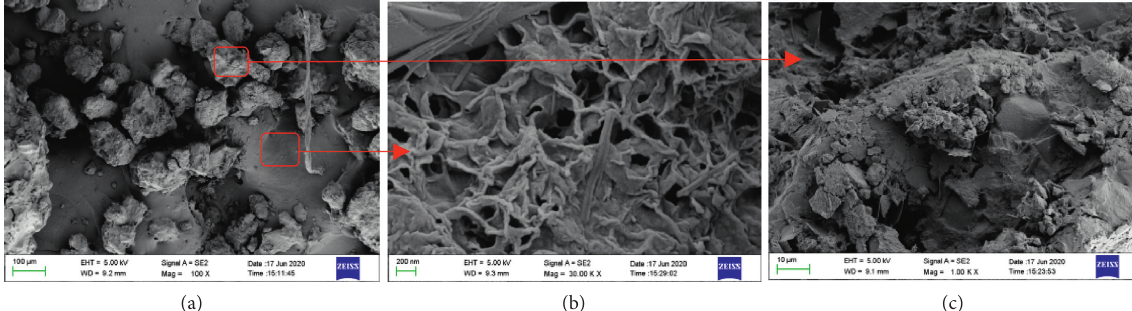
Figure 10: Microstructure of saline soils stabilised with Ca(OH) 2 and GGBS. (a) Close-up of specimen; (b, c) hydration products.